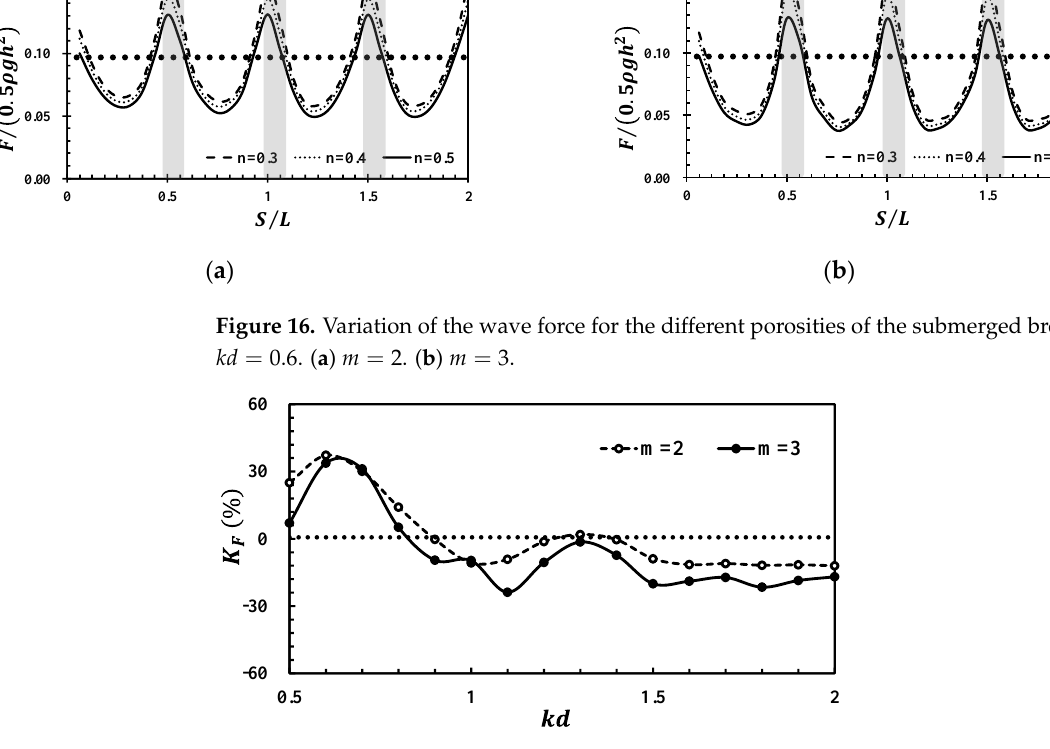
Figure 17. Variation of the ratio of the wave force 𝐾 𝐹 versus 𝑘𝑑 for the different structure config- urations.